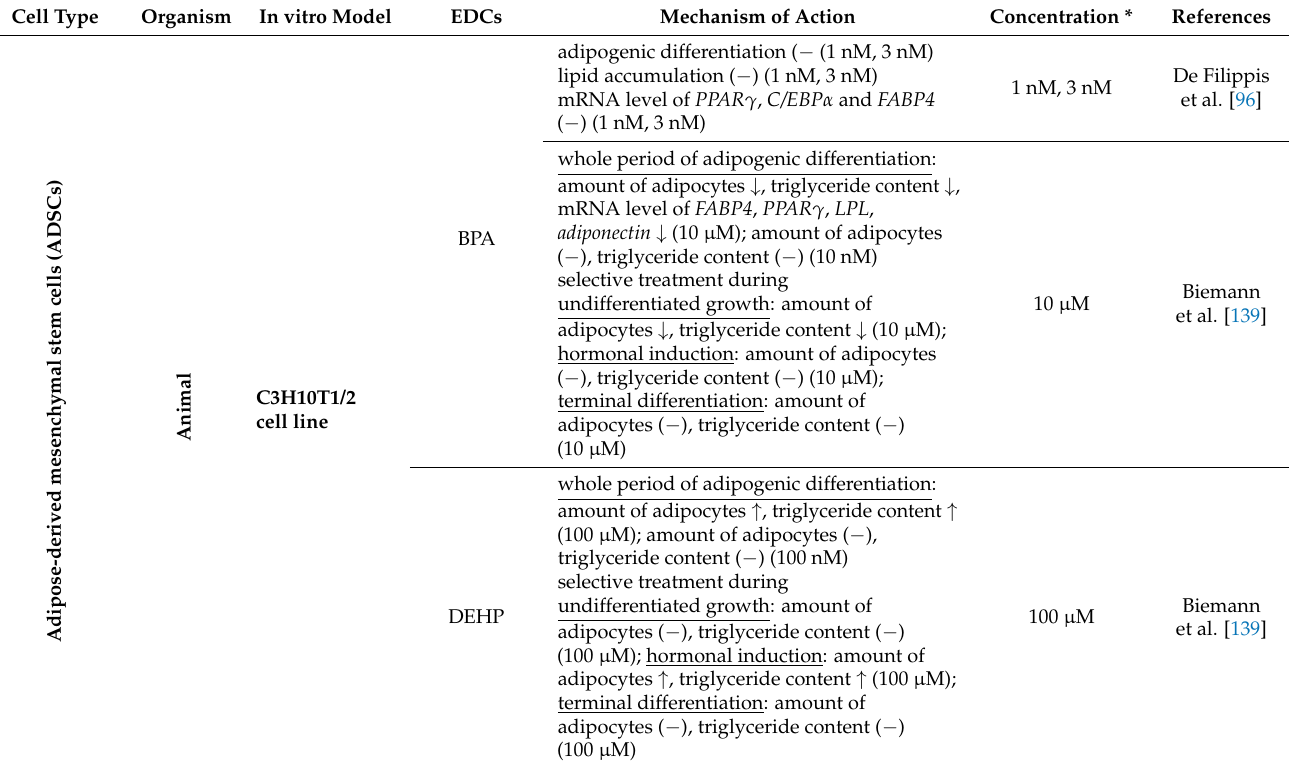
Table 2. The obesogenic effect of selected EDCs confirmed on mesenchymal stem cell